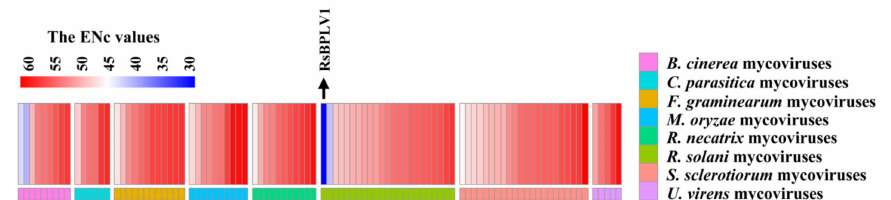
Figure 2. A heat map of the ENc (the effective number of codons) values of the selected mycoviruses, and it was drawn by pheatmap package in R. The legend was determined by the true ENc values of mycoviruses, the red represented the high value, the blue represented the low value, and the white represented the intermediate value among the 98 mycoviruses.